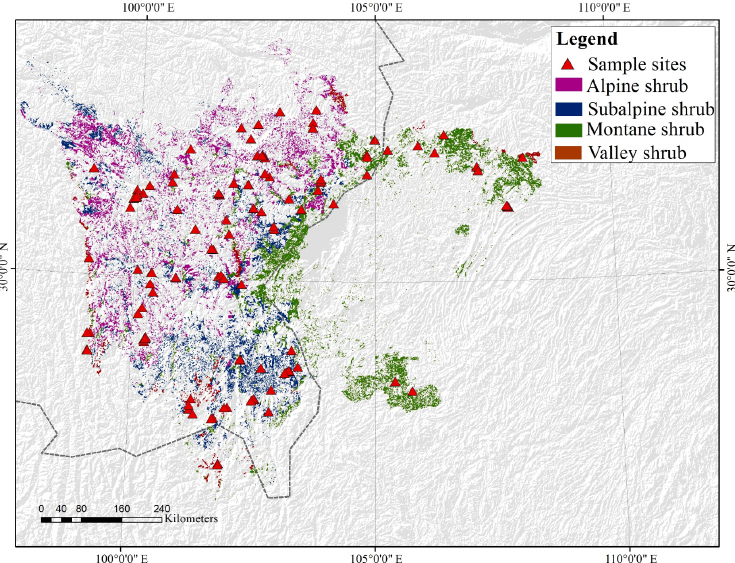
Figure 1. Locations of the southeastern Tibetan Plateau and 125 sample sites in mountainous areas. The purple, blue, green, and brown areas stand for the distribution of alpine, subalpine, montane and valley shrub types,